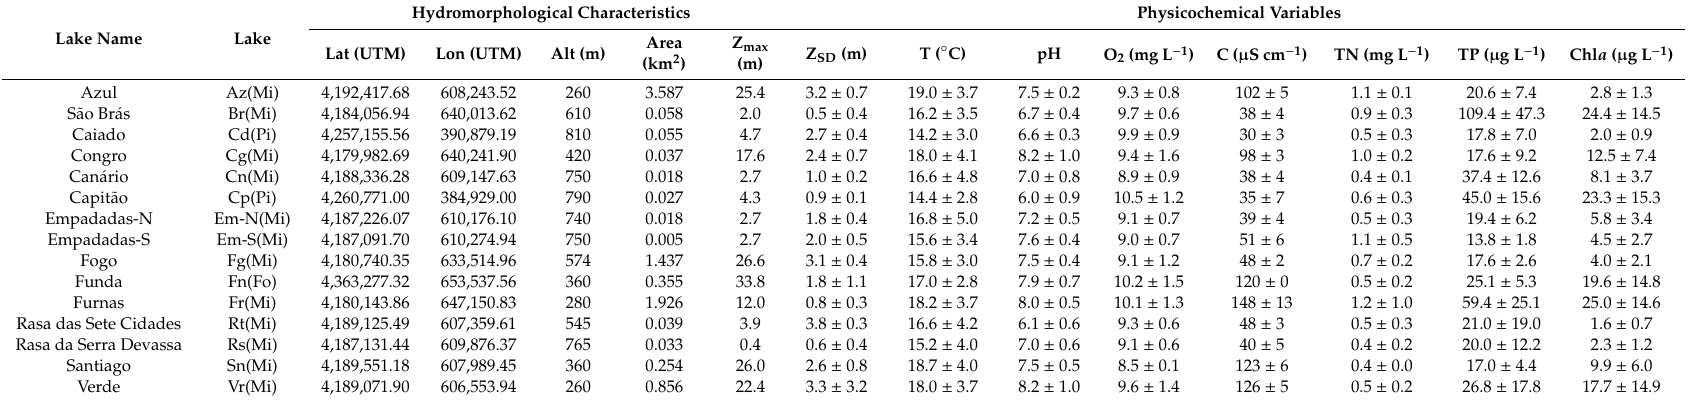
Table 1. Hydromorphological and physicochemical characterization of sampled